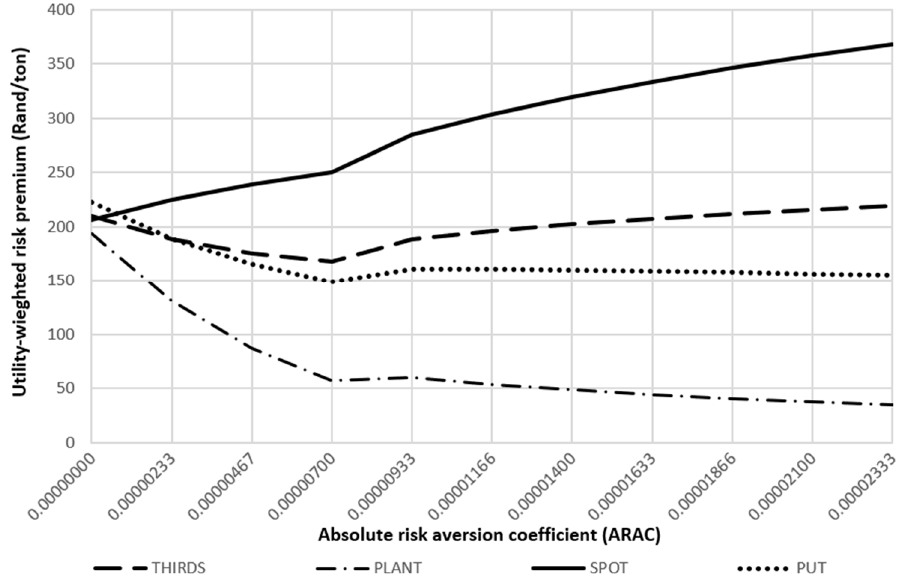
Figure 7. Utility weighted premiums between the efficient frontier moving average crossover (MAC) strategies and less preferred routine hedging strategies. Source: Author’s compilation.